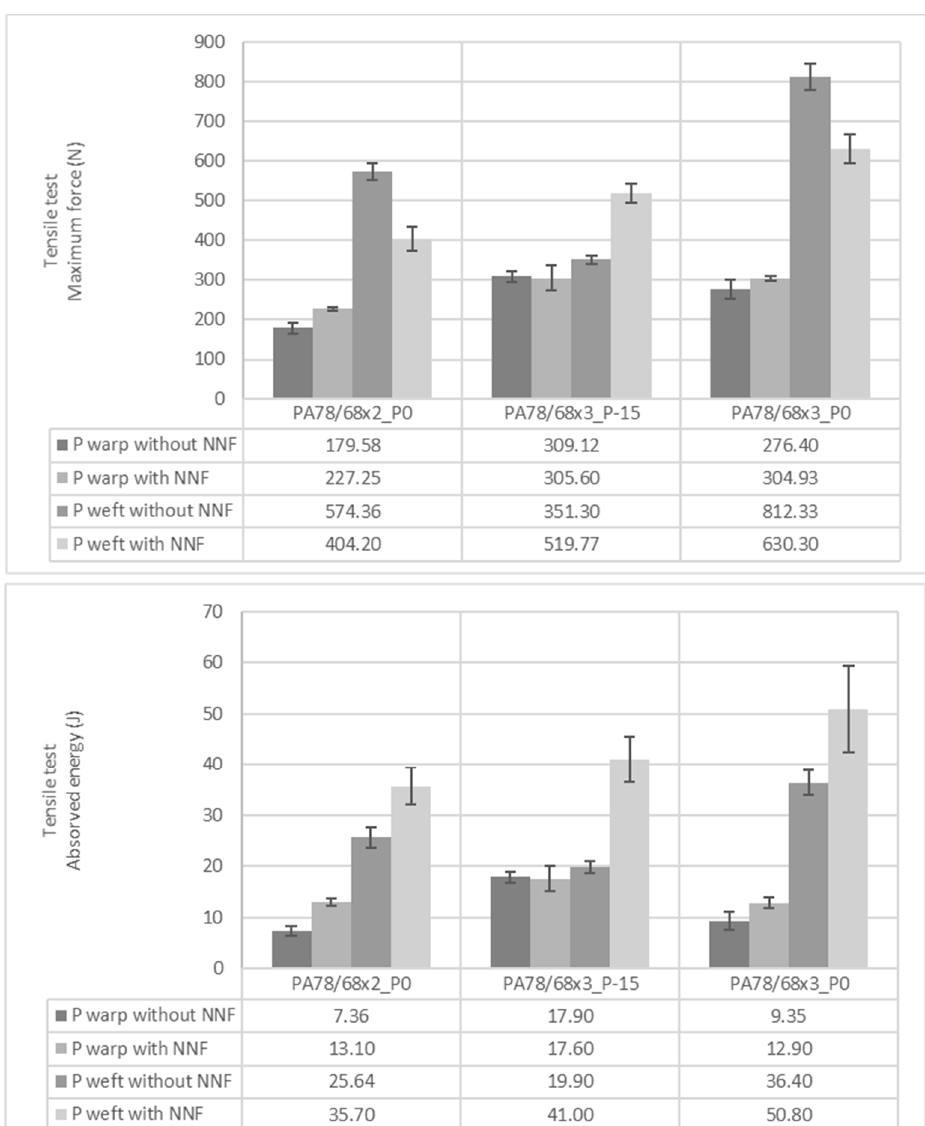
Figure 7. Maximum force and absorbed energy of knits with P pattern obtained on tensile tests.